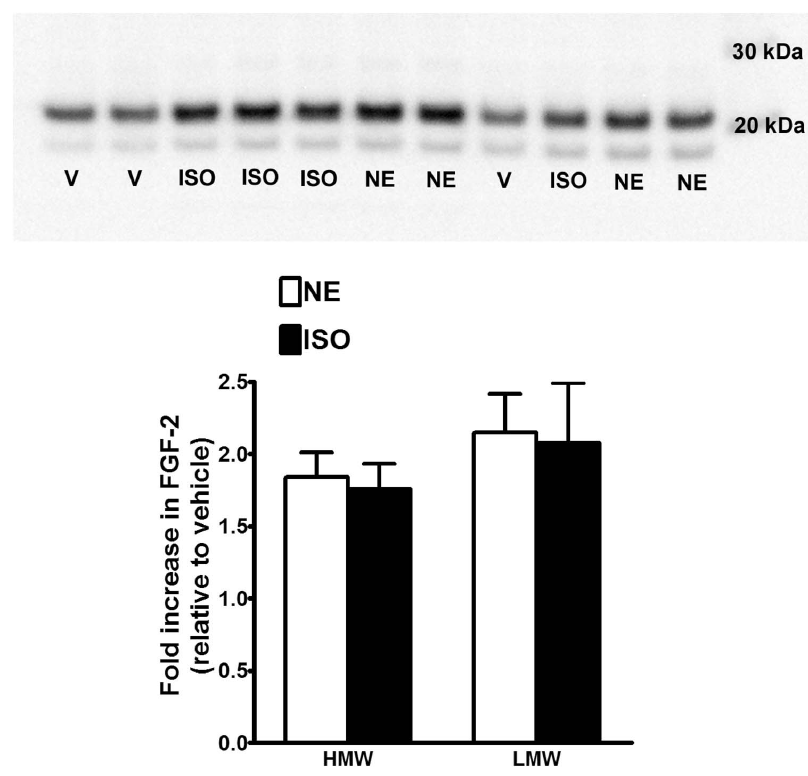
Figure 7. Norepinephrine and isoproterenol stimulate the production of high and low molecular weight forms of FGF-2 in astrocytes. Astrocytes were incubated in N/B27 media to which vehicle (V), norepinephrine alone (NE; 10 uM) or isoproterenol alone (ISO; 1 uM) were added just prior to 6 hr incubation. After 6 hr, astrocytes were harvested and cell lysates run on 10% reducing SDS-PAGE followed by immunoblotting for FGF-2 as described in Methods. FGF-immunoreactive bands ran at an approximate molecular weight of 23 kDa and 18 kDa, which are referred to as high molecular weight (HMW) and low molecular weight (LMW) isoforms, respectively. Data represent the mean 6 SEM of 6 independent